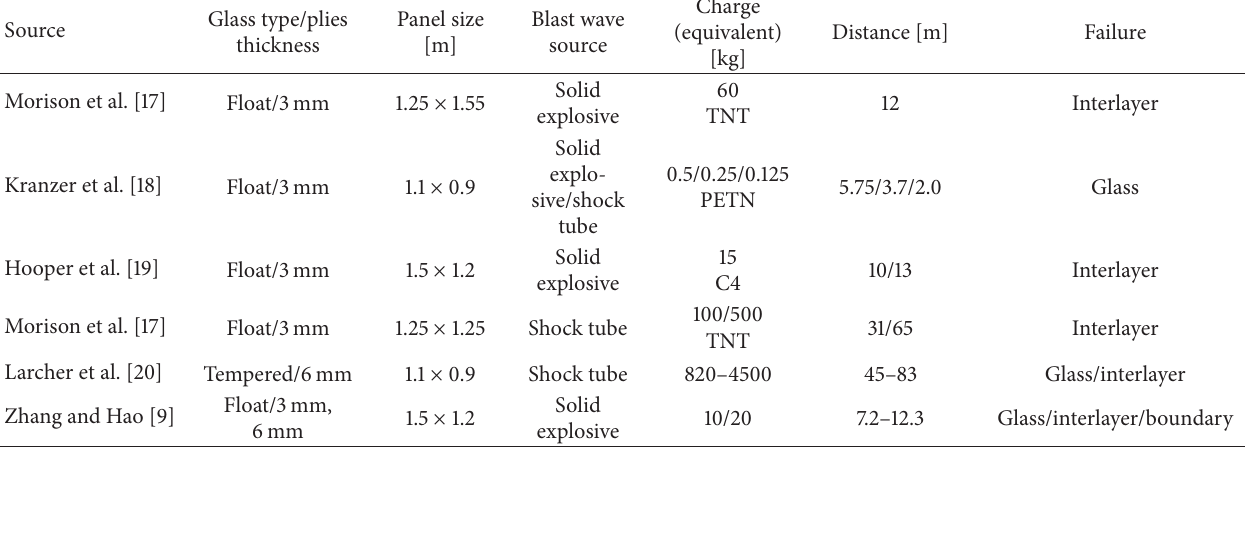
Table 5: Blast-loaded laminated glass experiments published in the open literature.